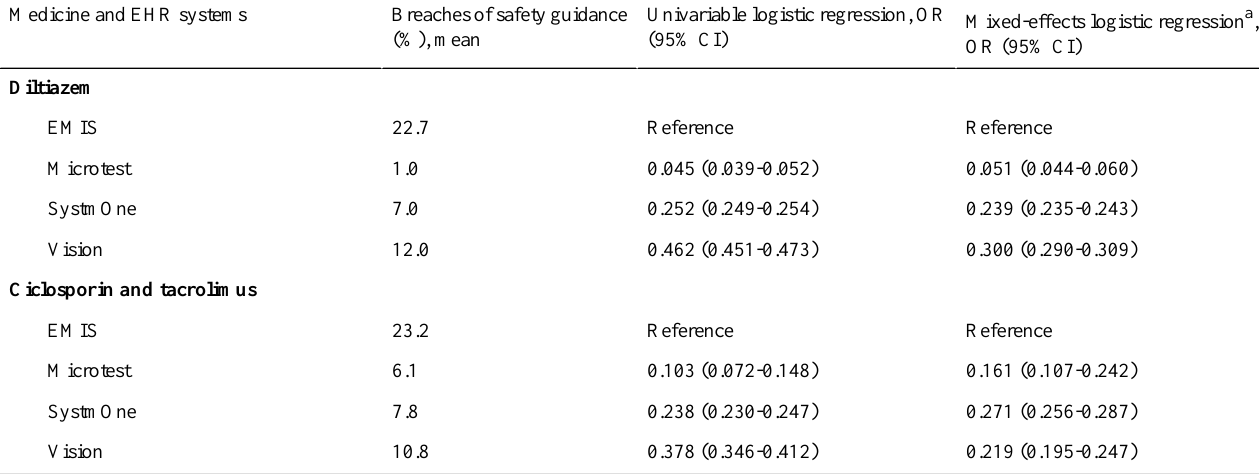
Table 2. Ciclosporin, tacrolimus, and diltiazem prescribing measures stratified by electronic health record (EHR) system along with odds ratios (ORs) from a univariable and multivariable logistic regression